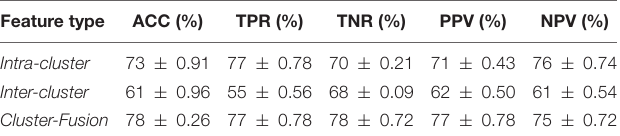
TABLE 3 | Experimental results of the application of similarity based sub-network